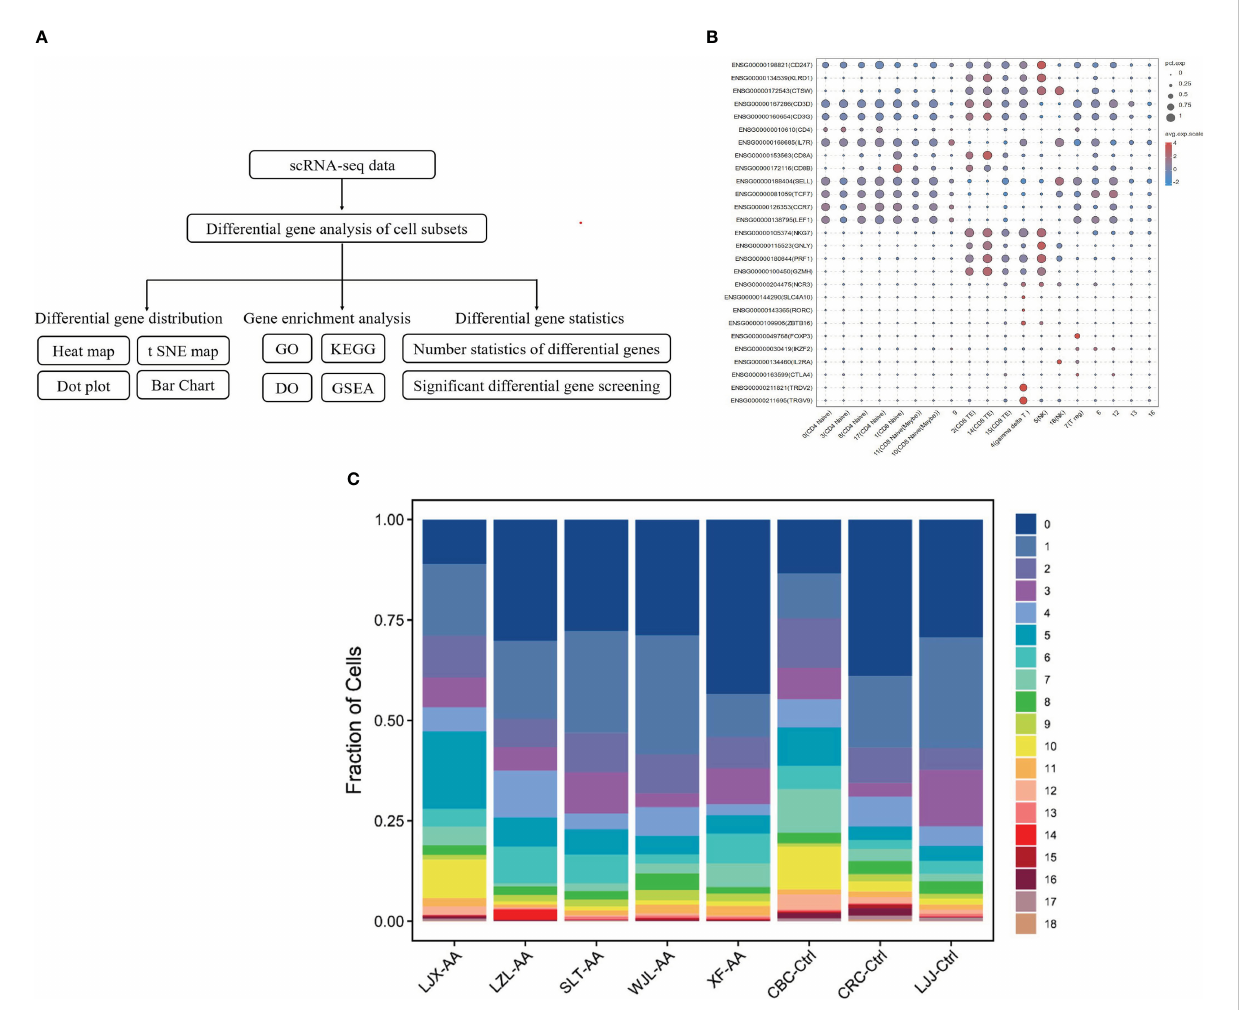
FIGURE 1 Identify cells and classify subsets with single-cell analysis. Schematic representation of the experimental design and single-cell mRNA sequencing (scRNA-seq) sequencing procedure (A) . The surface marker of immune cells was used to identify cells and classify subsets. Dot sizes represent percent expressed and dot colors represent the average-expressed scale (B) . Fraction of cell subsets ’ differences between groups. Colors indicate cell clusters with numbered labels (C)